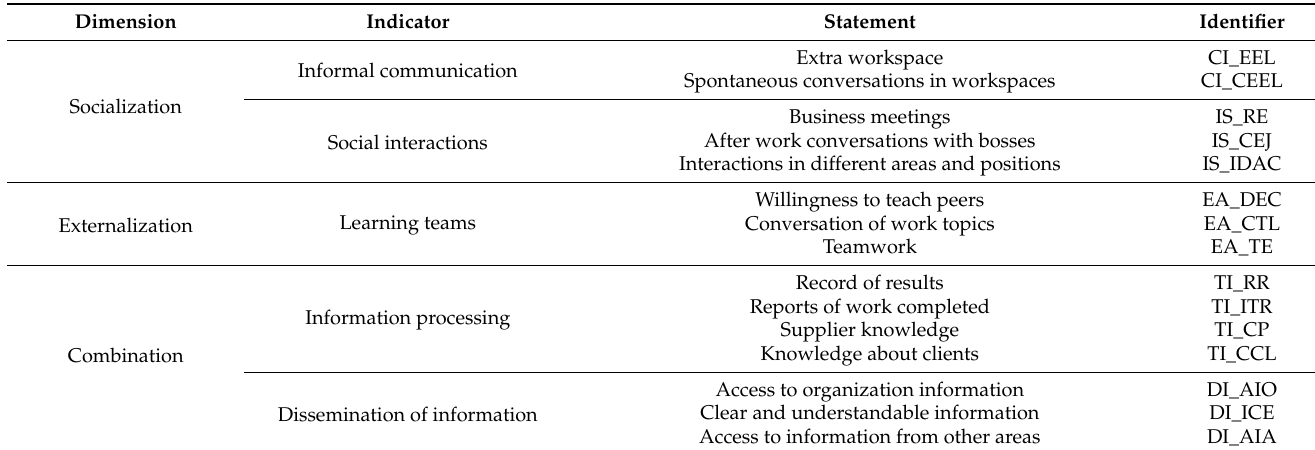
Table 7. Causes in the